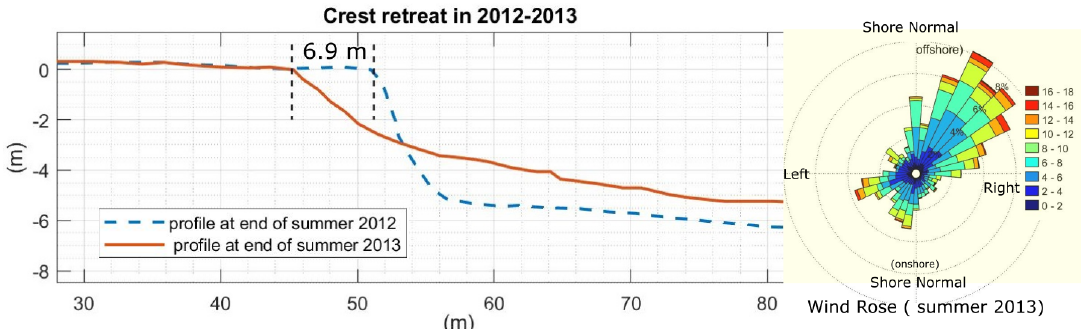
Figure 11. Case #1: The profile is situated in zone S1. Crest retreat of 6.9 m is recorded at the end of the summer of 2013. The wind rose diagram derived from the wind speed data of summer 2013 is shown at the right panel. The diagram is adjusted 49.28° so that shore-normal (offshore) direction is in the top. The wind rose diagram indicates that the dominating wind direction is inclined about 30° towards the shoreline.